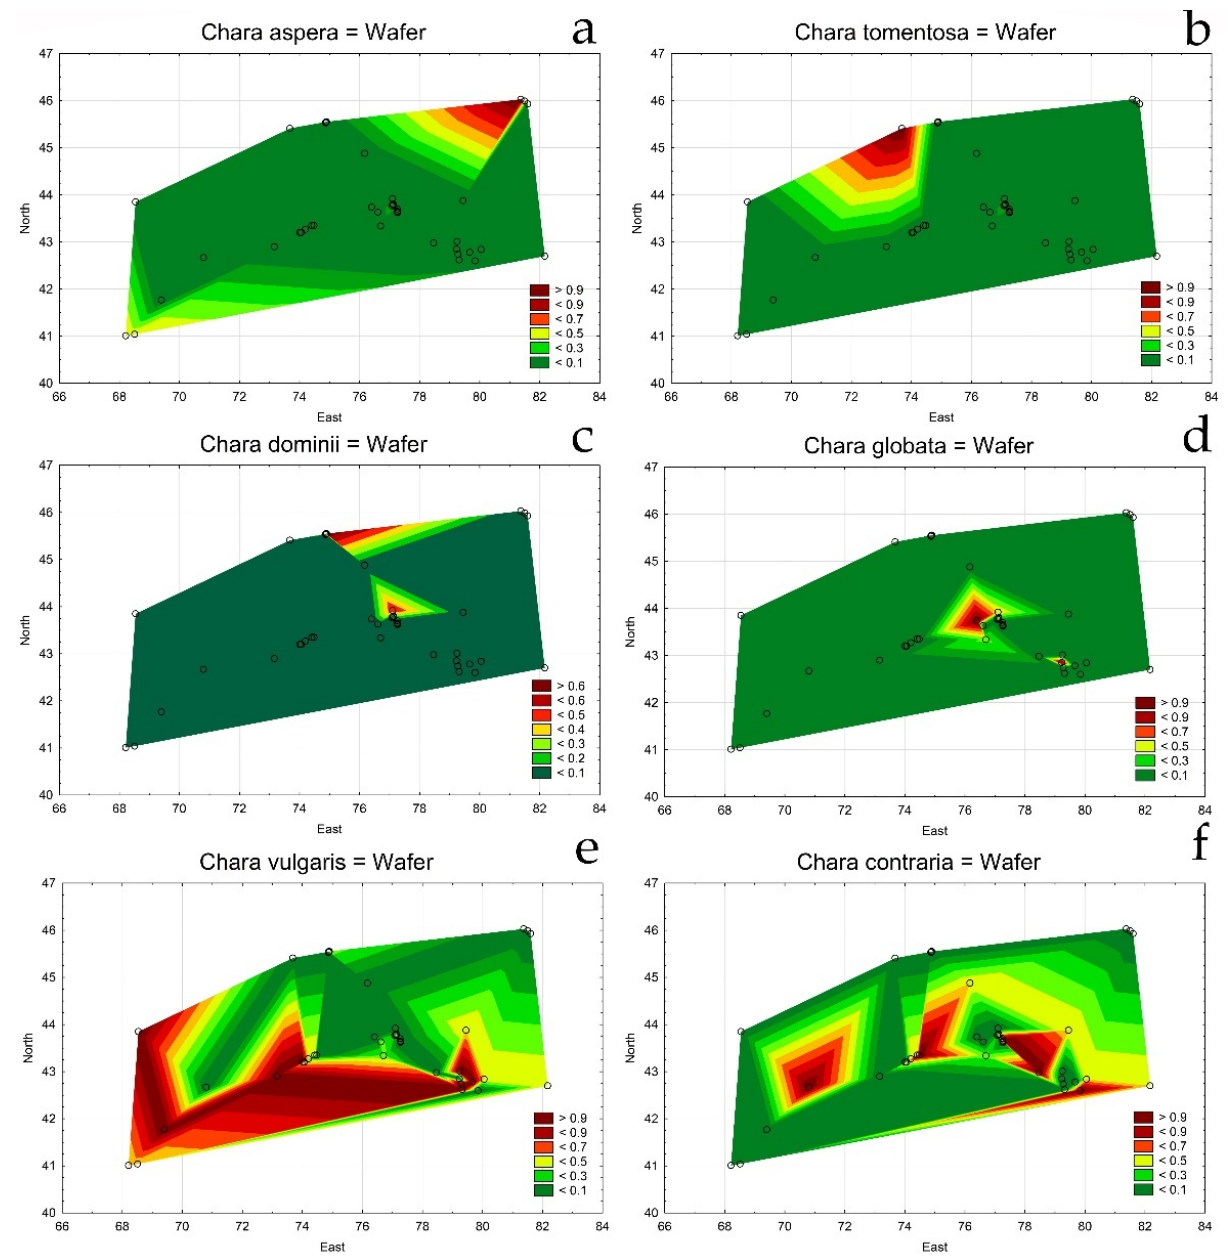
Figure 3. Statistical maps for Chara species distribution on the studied area of south and southeast Kazakhstan in 2019–2022. Chara aspera ( a ); Chara tomentosa ( b ); Chara domini ( c ); Chara globata ( d ); Chara vulgaris ( e ); Chara contraria ( f ). The legend key shows the species relative value. Comparing the species and environmental variables distribution maps allowed us to presume that Chara vulgaris , the most distributed species in south and southeast Kaza- khstan, preferred low altitude habitats with high water temperatures, organic enrichments (increased values of BOD), and color, but low oxygen and pH. Other species, e.g., C. aspera